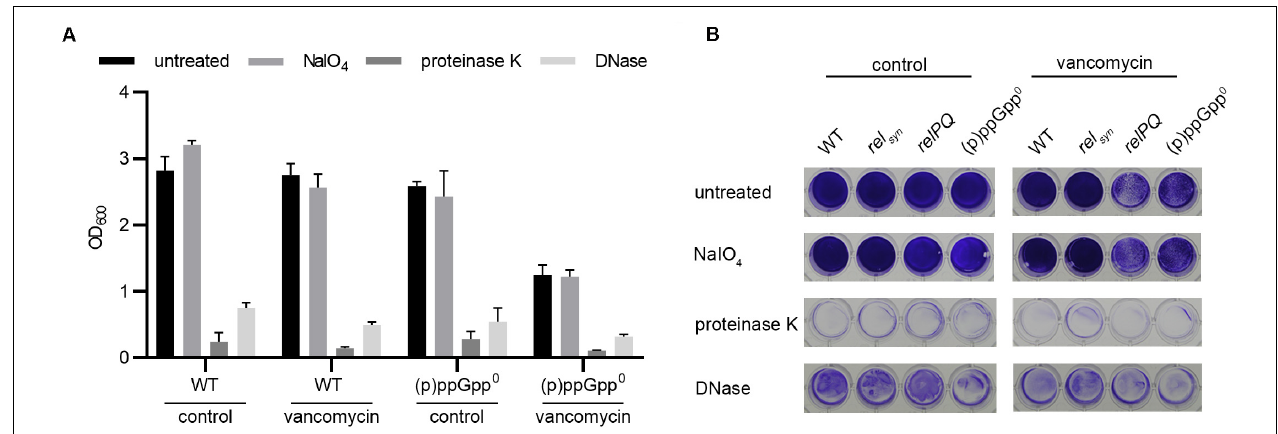
FIGURE 3 | Biofilm composition is not affected by (p)ppGpp. (A) Preformed biofilms of the wild type and the isogenic (p)ppGpp 0 strain were treated with either DNase or proteinase K for 4 h at 37 ◦ C or with sodium periodate for 24 h at 4 ◦ C. The remaining biofilm was stained with crystal violet and quantified by OD 600 measurement. Three separate experiments were performed with biological triplicates each. Error bars represent the standard deviation. (B) Representative plate with wild type, rel syn , relPQ and the (p)ppGpp 0 strain stained with crystal violet.